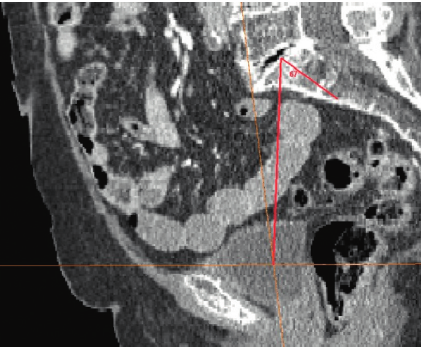
Figure 2: Pelvic